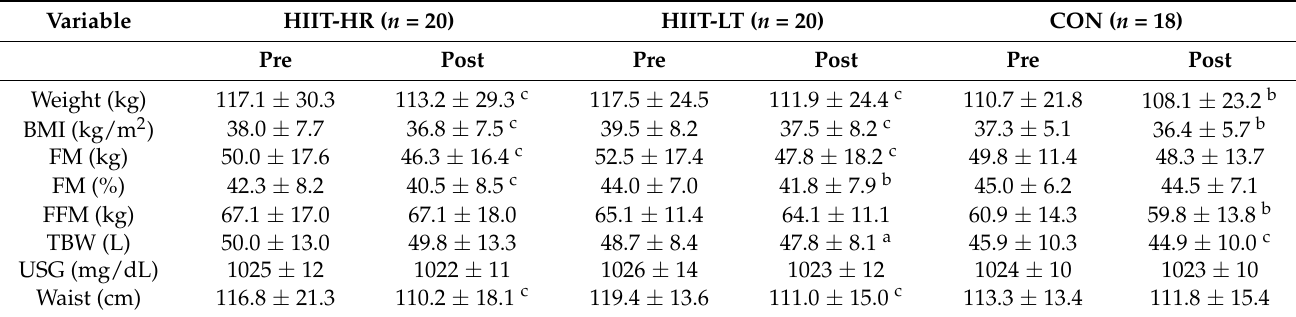
Table 2. Anthropometric and hydration